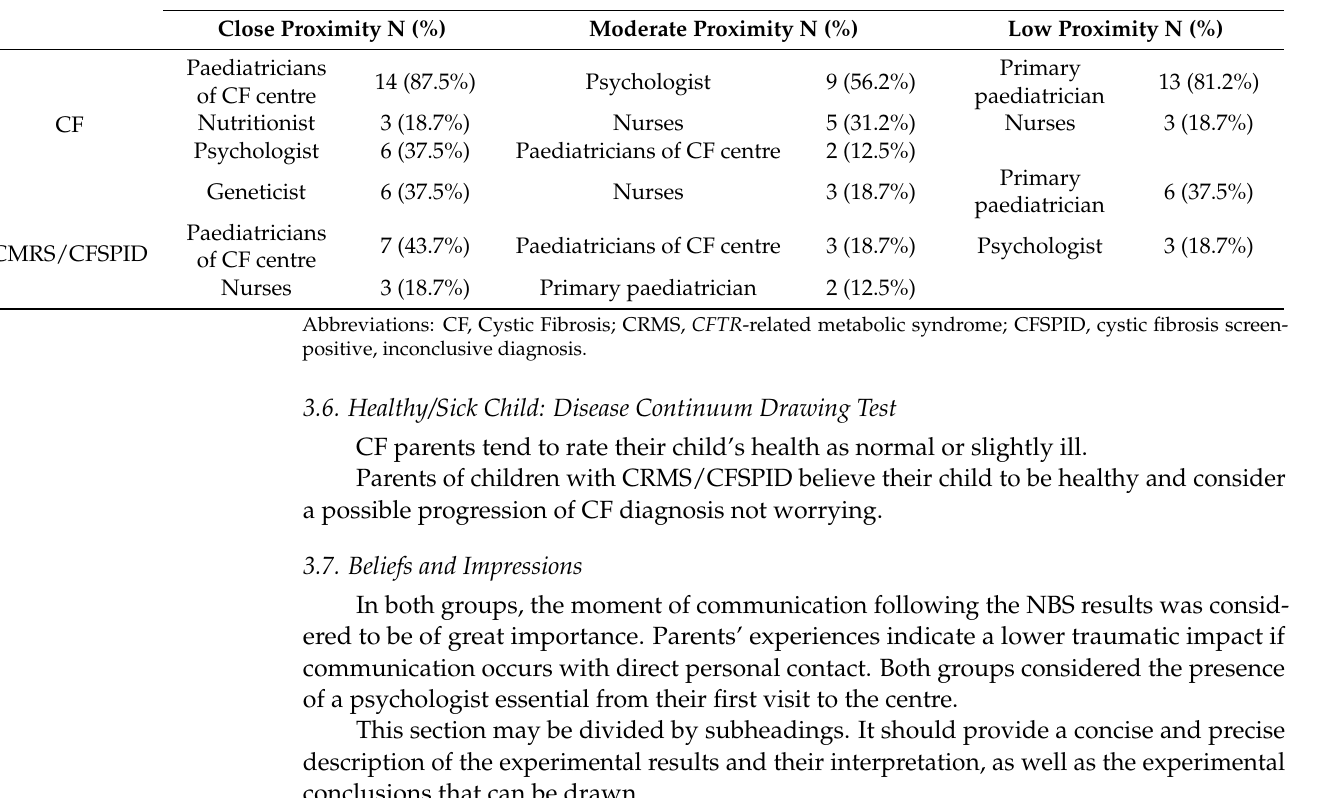
Table 6. Relations with healthcare for parents of children with CRMS/CFSPID and CF. Relations with